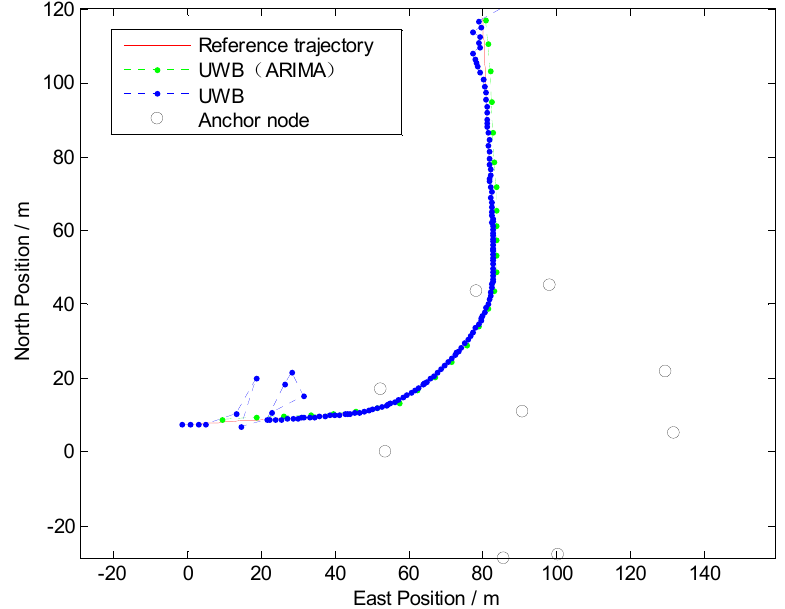
Figure 8. Positioning results in Trajectory II (Right Turn).